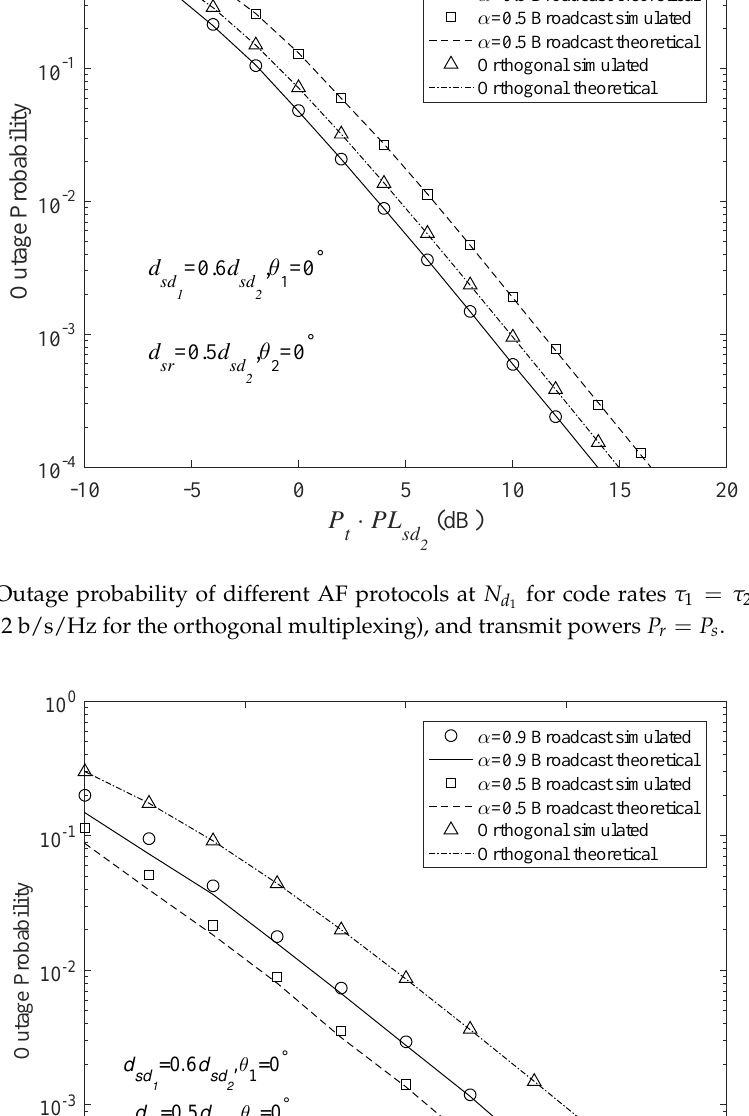
for code rates τ 1 = τ 2 = 1 b/s/Hz 2